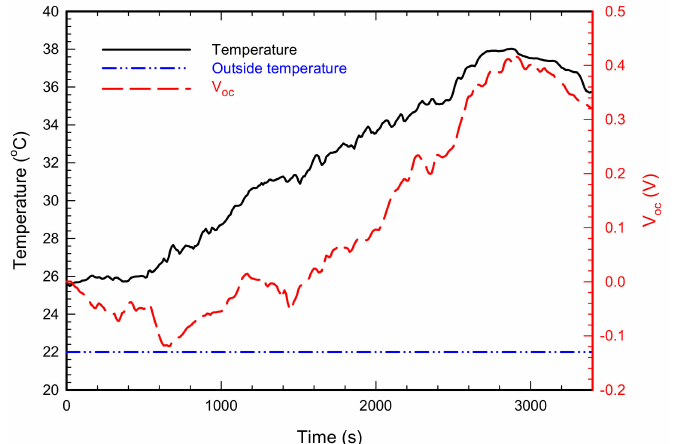
Figure 11. Measurement result of housing surface temperature and output voltage of the TEHS during Osong–Dongdaegu